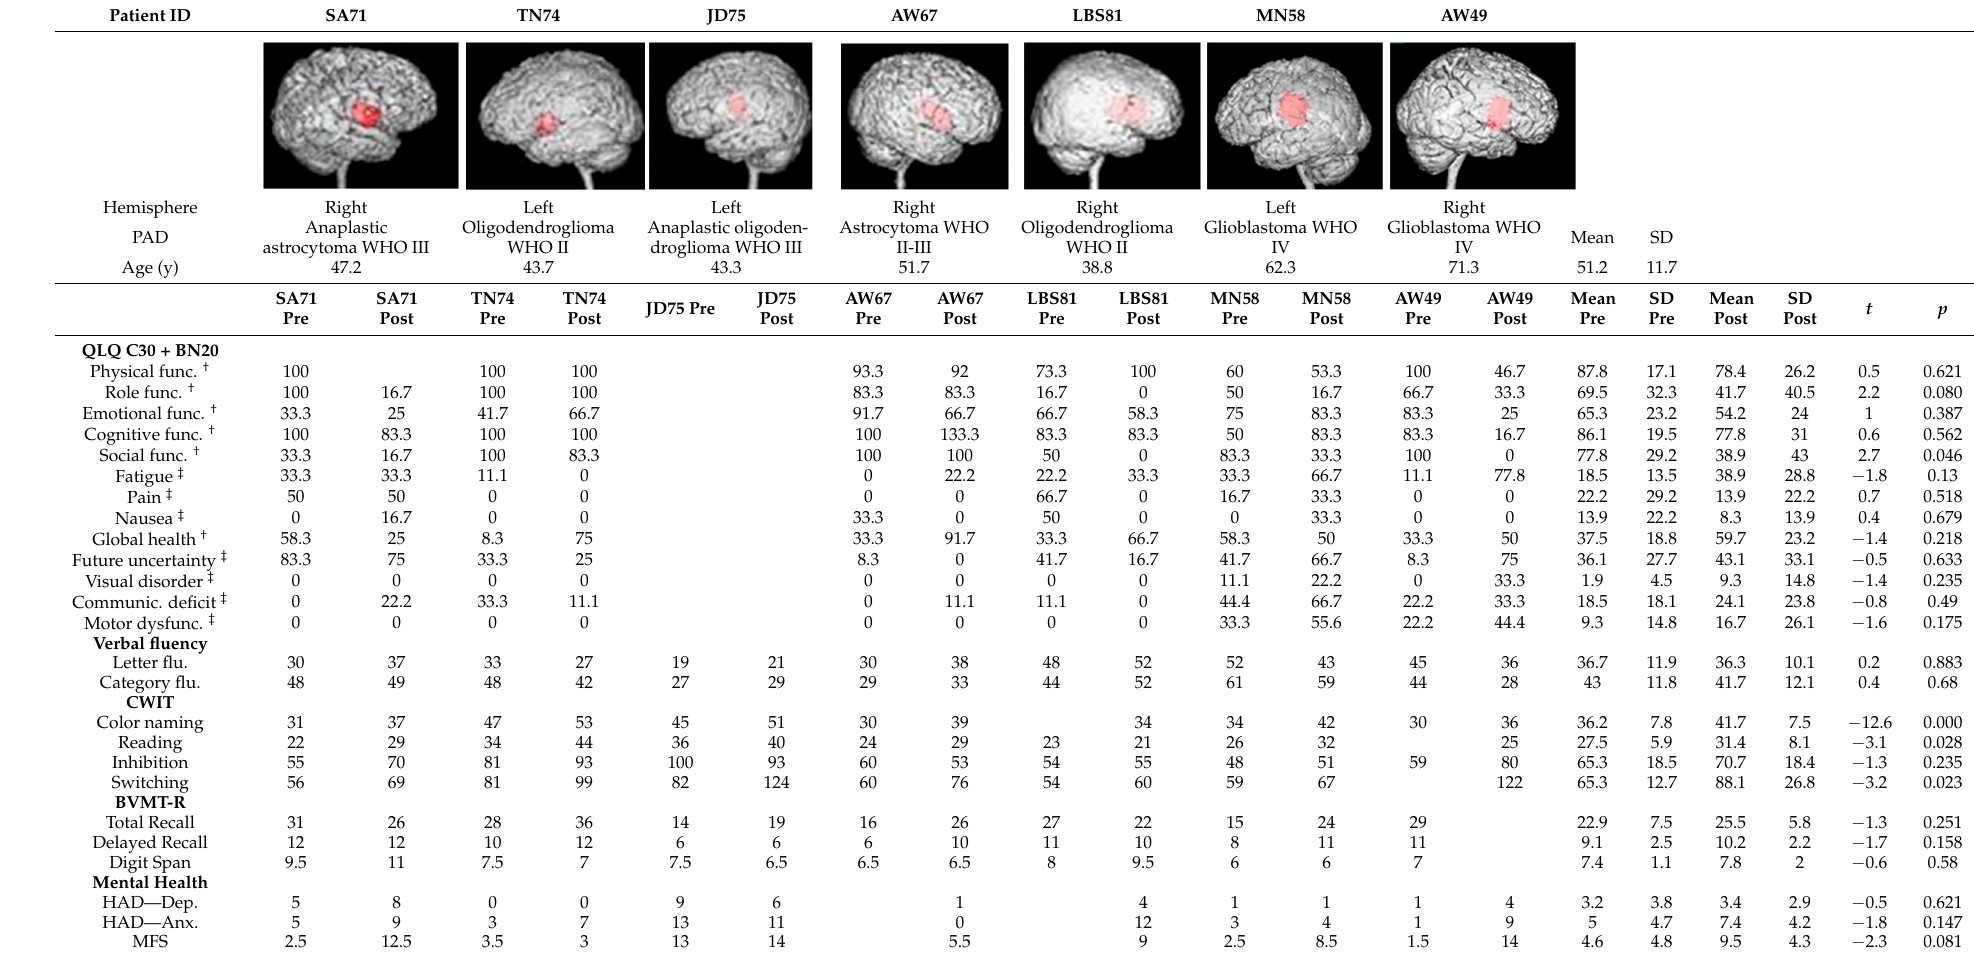
Table 2. Patient characteristics, QoL, cognitive function and mental health.